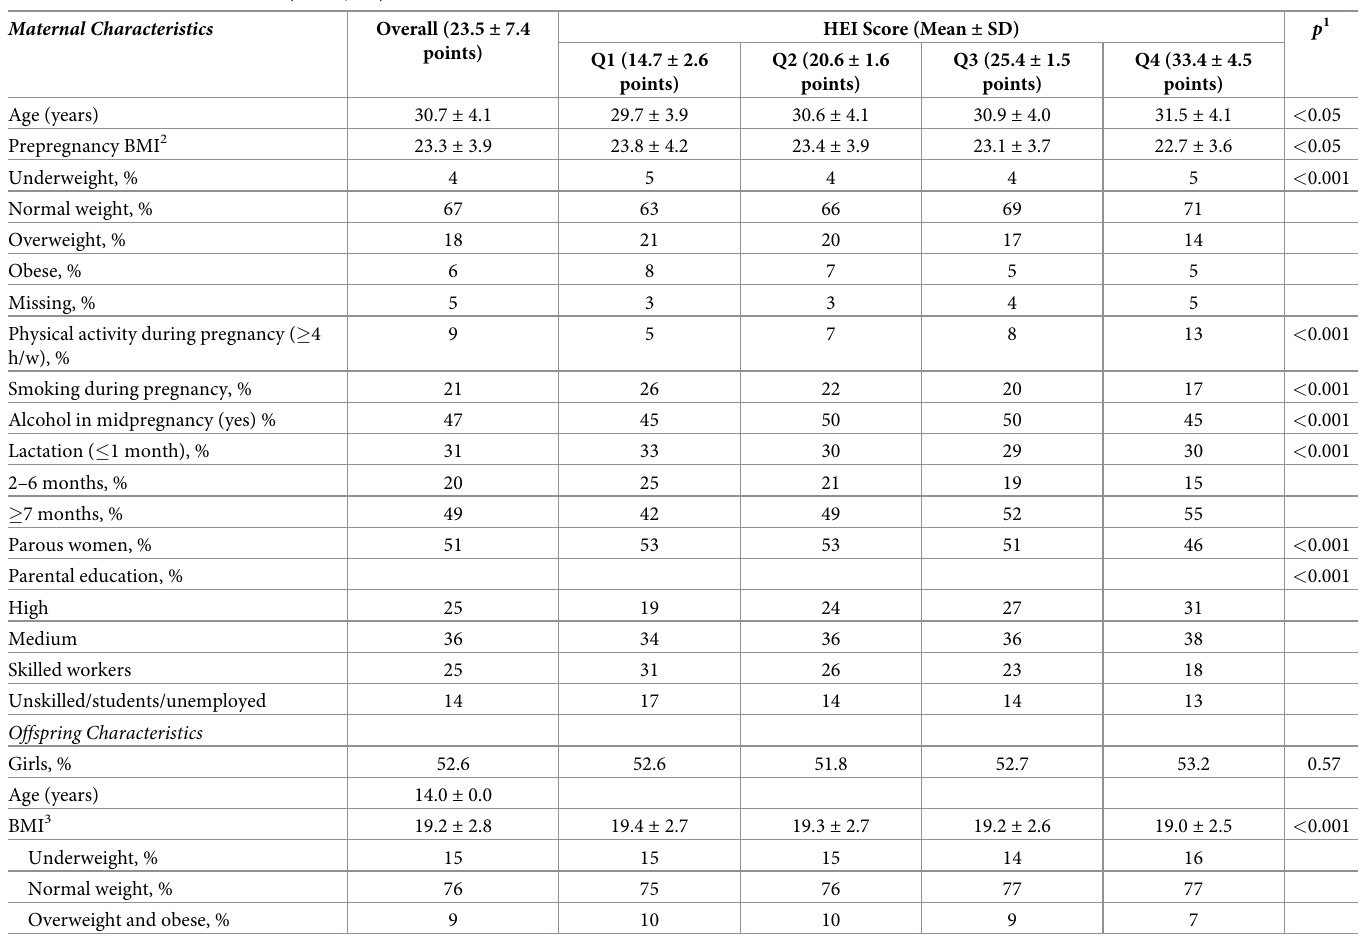
Table 2. Maternal characteristics ( n =